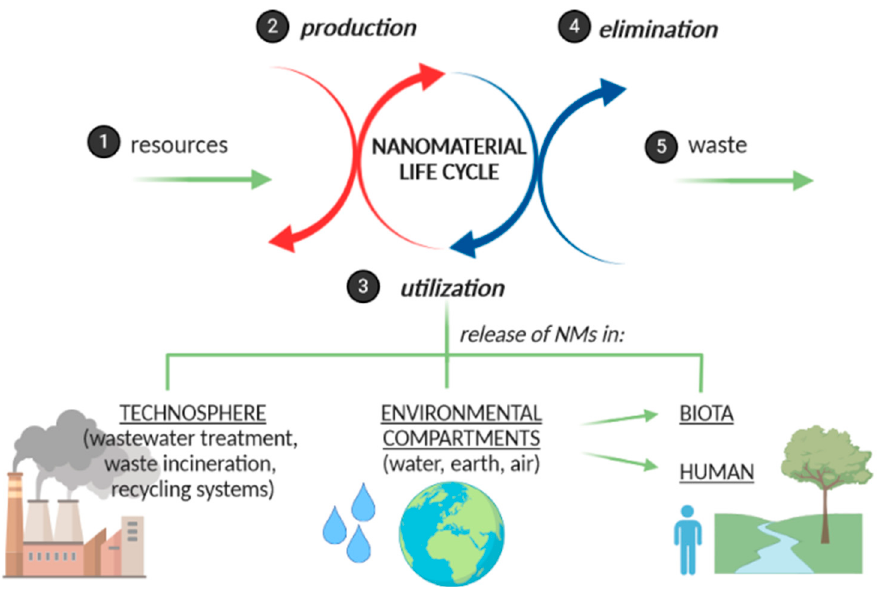
Figure 1. The impact of nanomaterial life cycle on the environment .